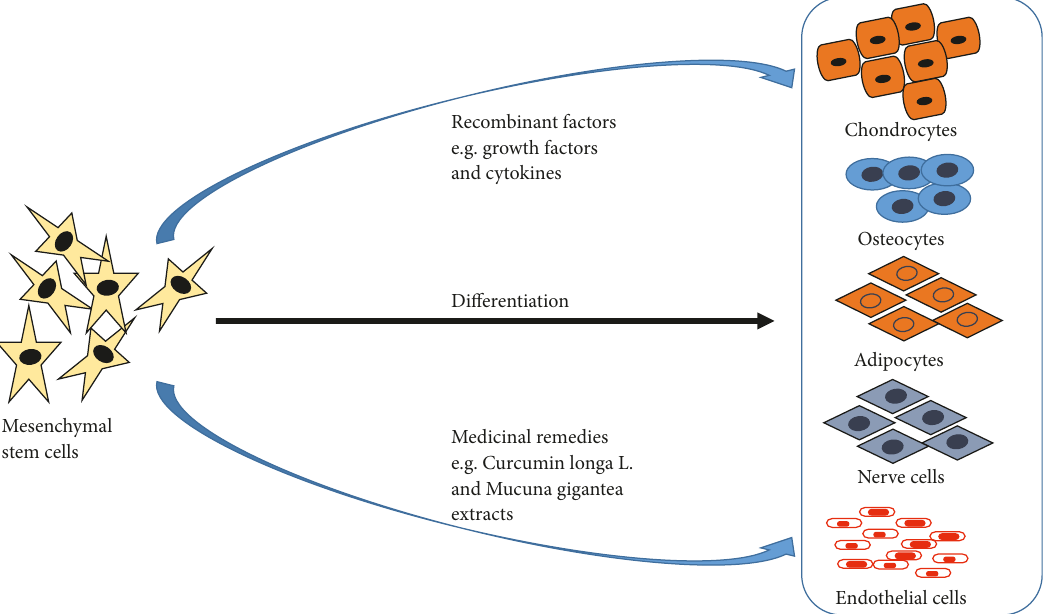
Figure 4: Stem cells such as mesenchymal stem cells can be di ff erentiated through the use of synthetic factors and/or medicinal remedies into di ff erent cell types. Medicinal remedies have the advantage of causing less side e ff ects and being very